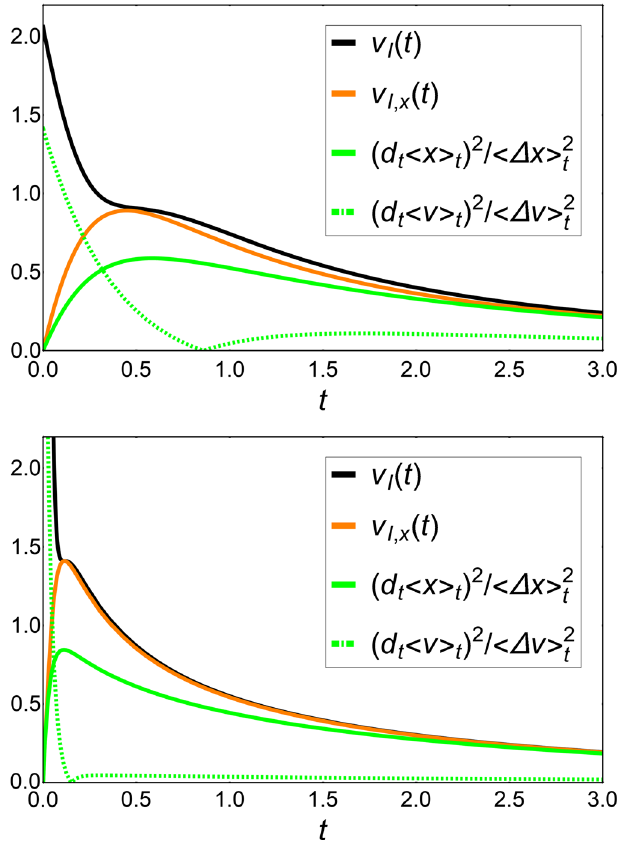
ffiffiffiffiffiffiffiffi p t Þ ¼ I ð t Þ I ð T ¼ 2 , γ ¼ 1 , κ ¼ 1 , B